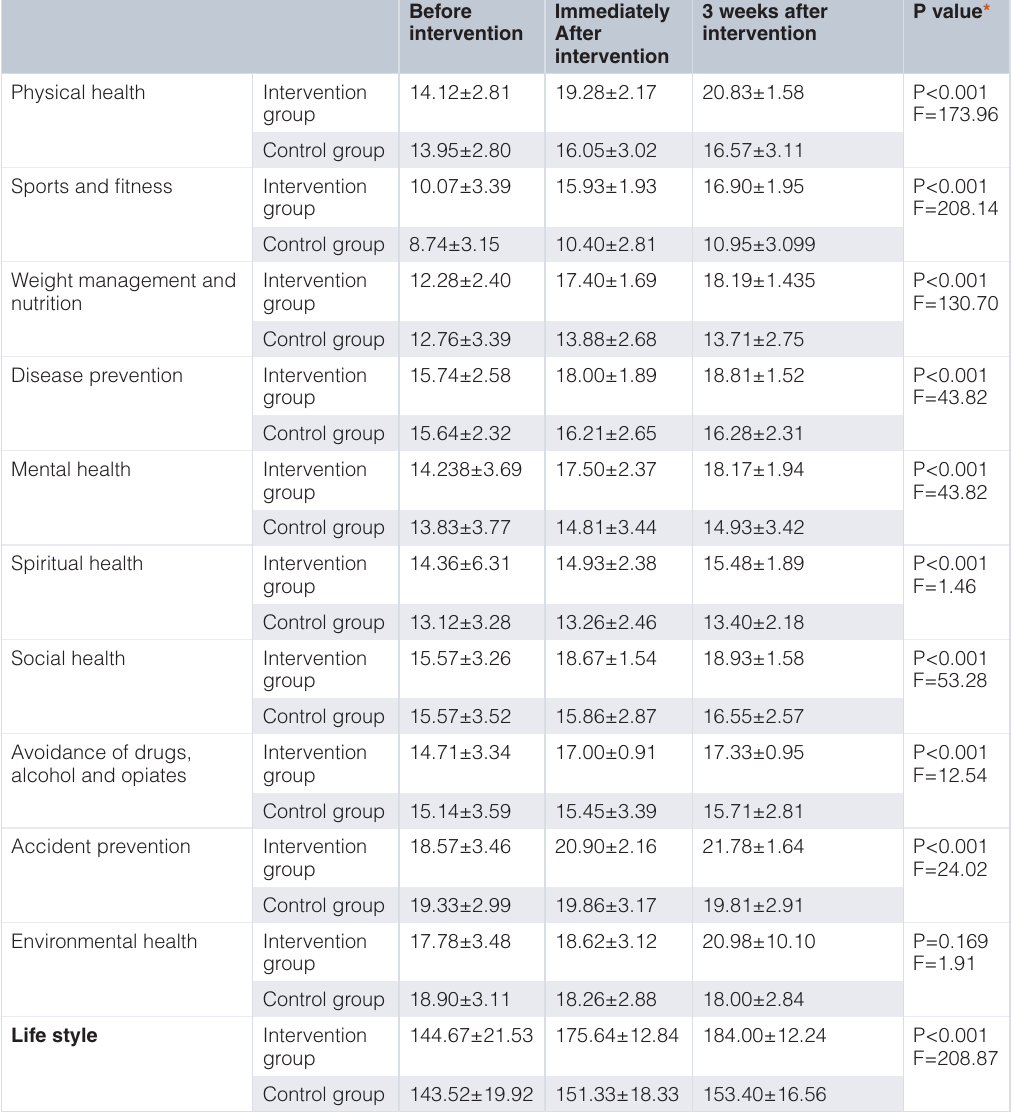
Table 2. Comparing the overall mean score of lifestyle in the control group and the intervention group before, immediately after and three weeks after (follow-up) the intervention in women with high-risk pregnancy presenting to selected health centers in Alborz province in 2017.